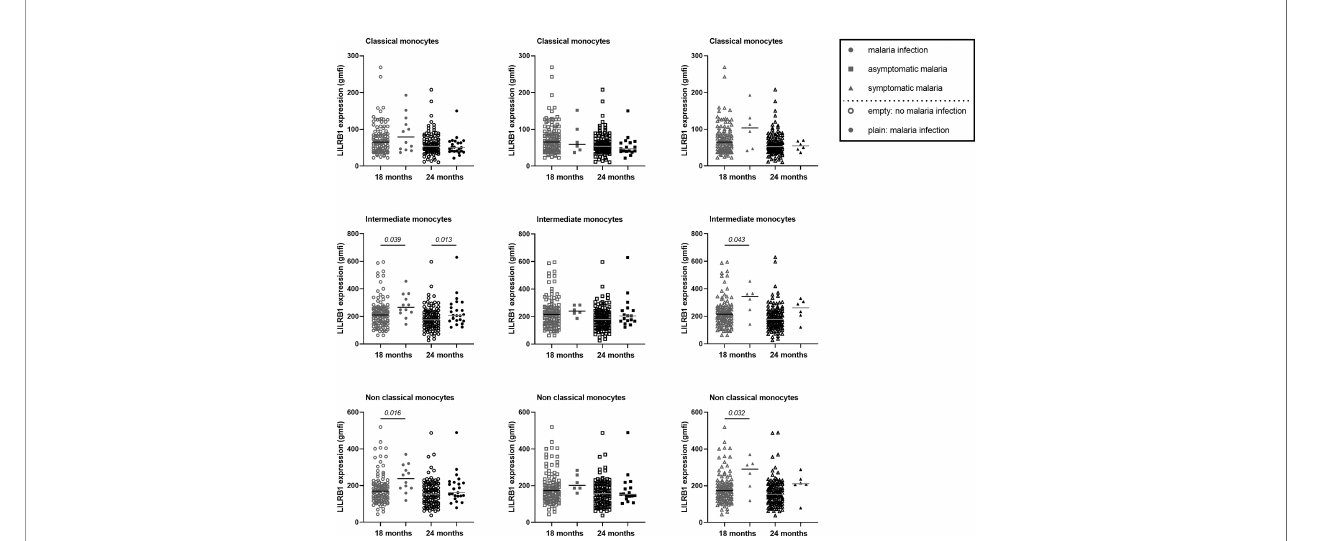
FIGURE 3 | Higher expression of LILRB1 on intermediate and non-classical monocytes at 18 and 24 months of age during active malaria. The expression of LILRB1 on immune cells was measured with the geometric mean of fl uorescence intensity (gm fi ) between Pf -infected and not-infected infants at 18 or 24 months of age. Total, asymptomatic or symptomatic malaria infections were represented with plain circle, square and triangle respectively. No infection at the visit was represented with empty symbols. The horizontal dark line in the beeswarm plot represents the median value. The number of infants with total, asymptomatic or symptomatic malaria infections varies between 6 and 23 for all monocyte subtypes. A linear regression (univariate analysis) was performed to compare the expression between the two groups of infants. P values are indicated in